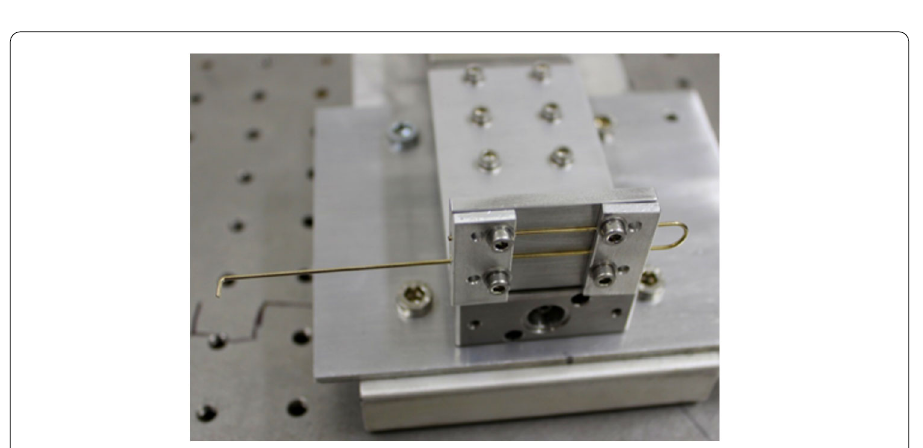
Figure 10 The spring element of the DEPB balance is a single bent wire. The contact point is the bent end on the left, which has a smooth rounded